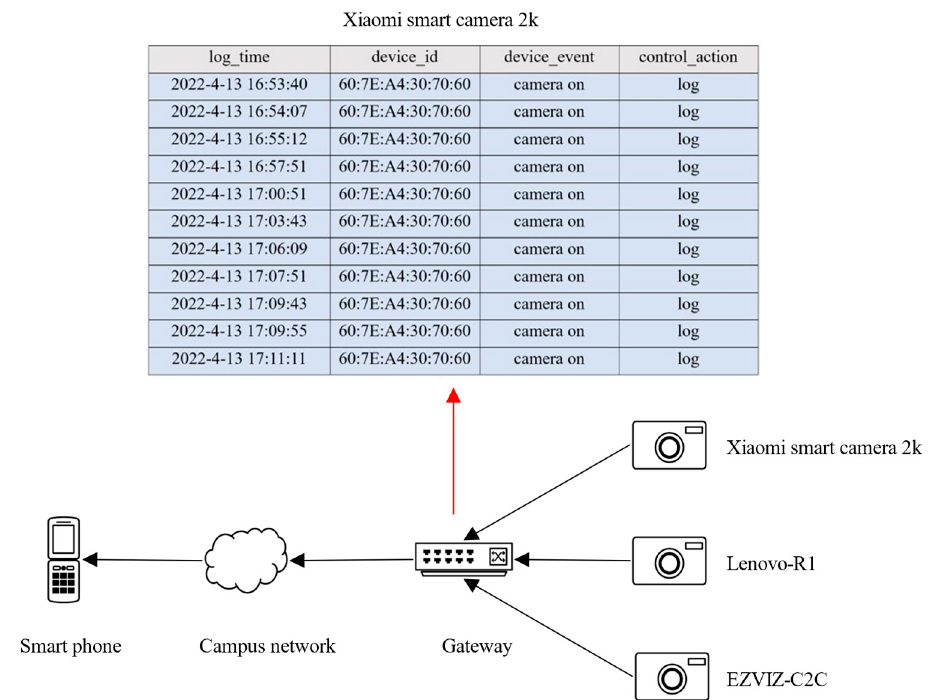
Figure 15. Device event detection.